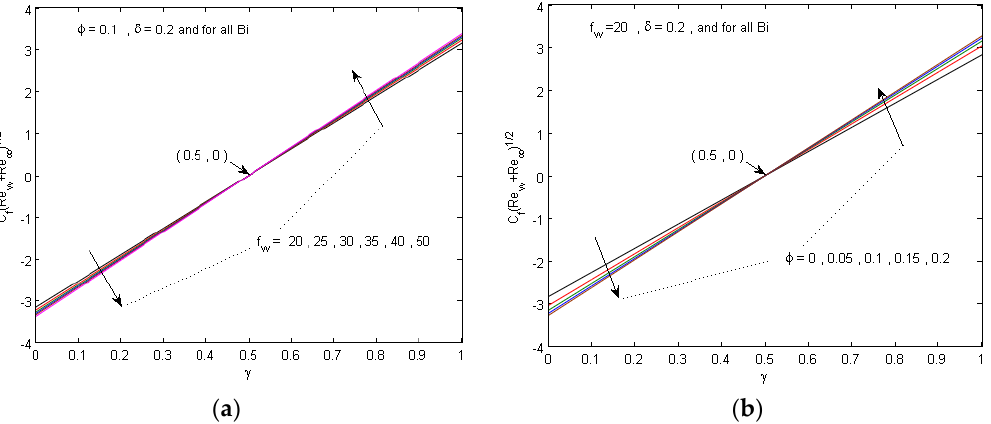
Figure 8. Local skin friction coefficient for various values of ( a ) suction parameter f w and ( b ) nanoparticle volume fraction parameter φ .